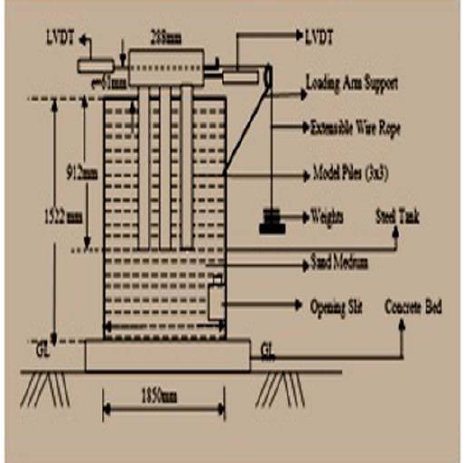
Fig. 2. Experimental set-up for lateral load tests .